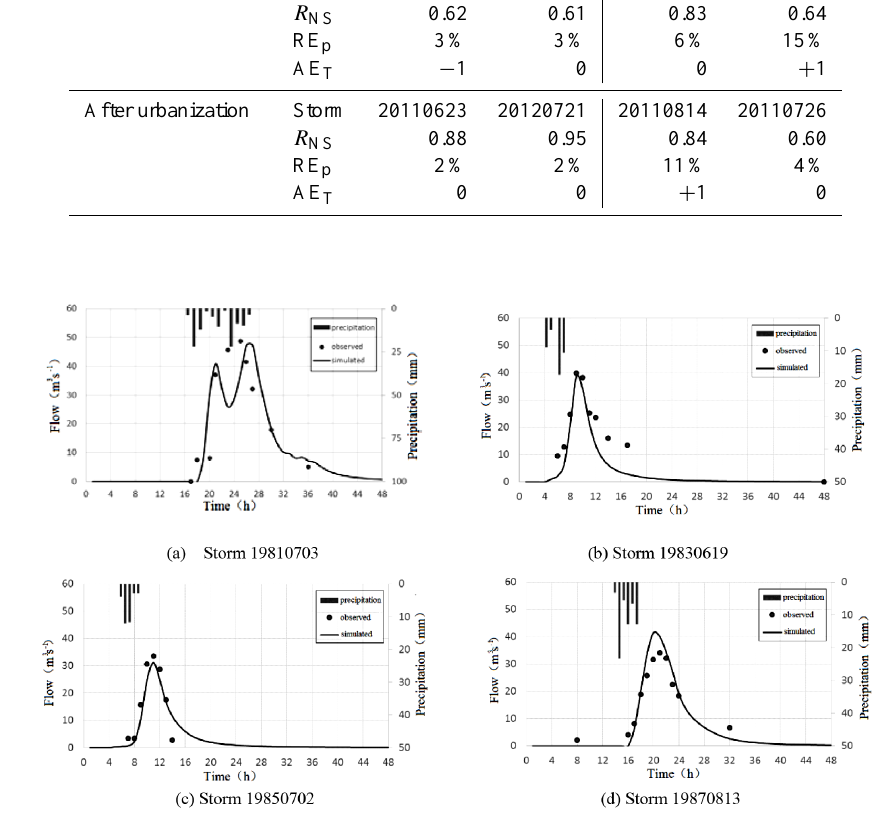
Figure 4. Simulation of flood before urbanization.